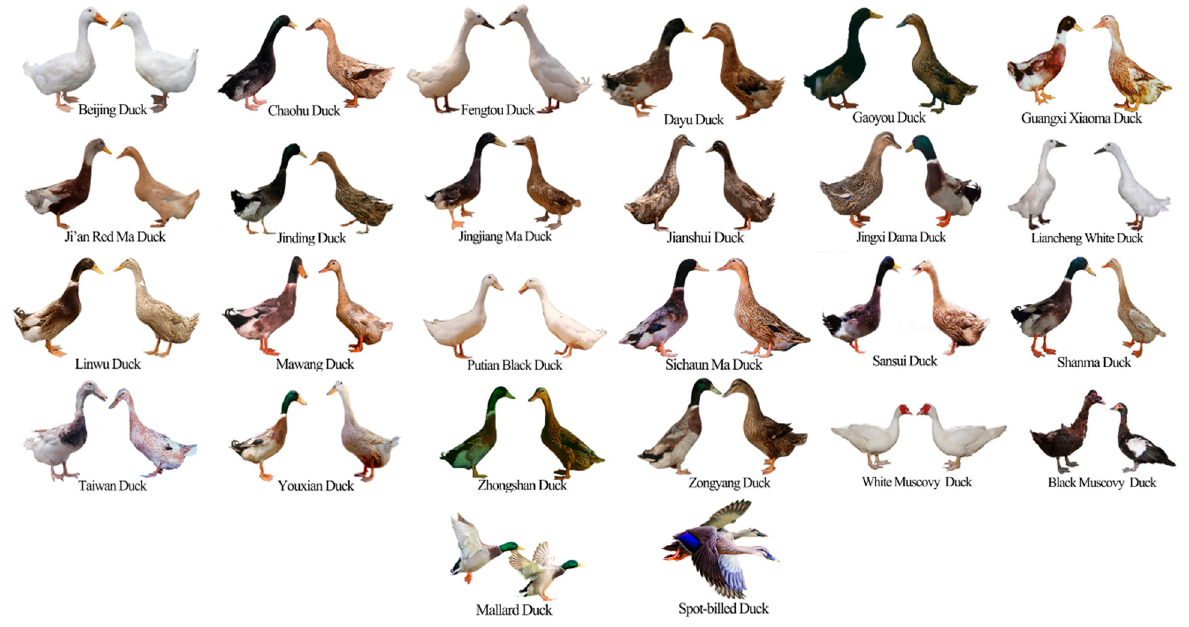
Figure 1. Images of 26 individual duck populations. Images were captured with a digital camera (Olympus, Japan). High-resolution images of each representative duck population are shown in Supplementary Figure S1.